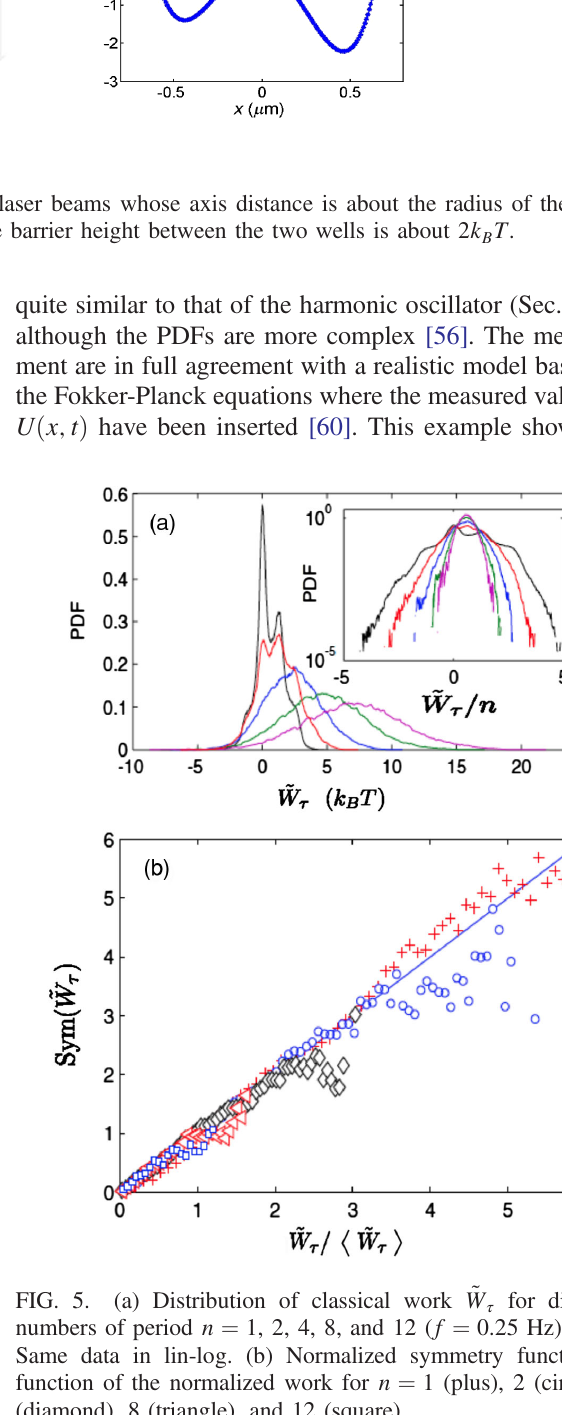
FIG. 5. (a) Distribution of classical work numbers of period n ¼ 1 , 2, 4, 8, and 12 ( f ¼ 0 . 25 Hz). Inset: Same data in lin-log. (b) Normalized symmetry function as function of the normalized work for n ¼ 1 (plus), 2 (circle), 4 (diamond), 8 (triangle), and 12